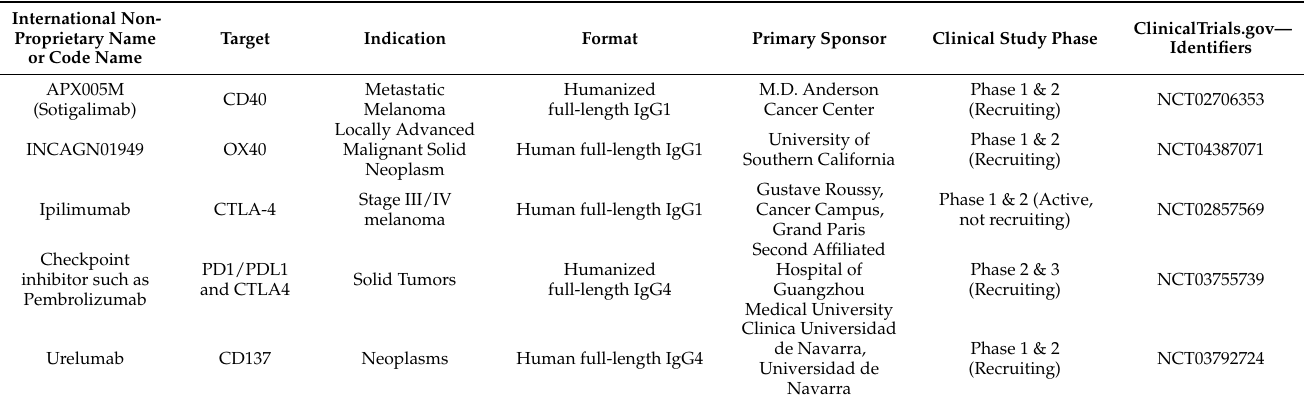
Table 7. Therapeutic antibodies in development delivered by intra-tumoral administration, currently in phases 2 and 3 of clinical